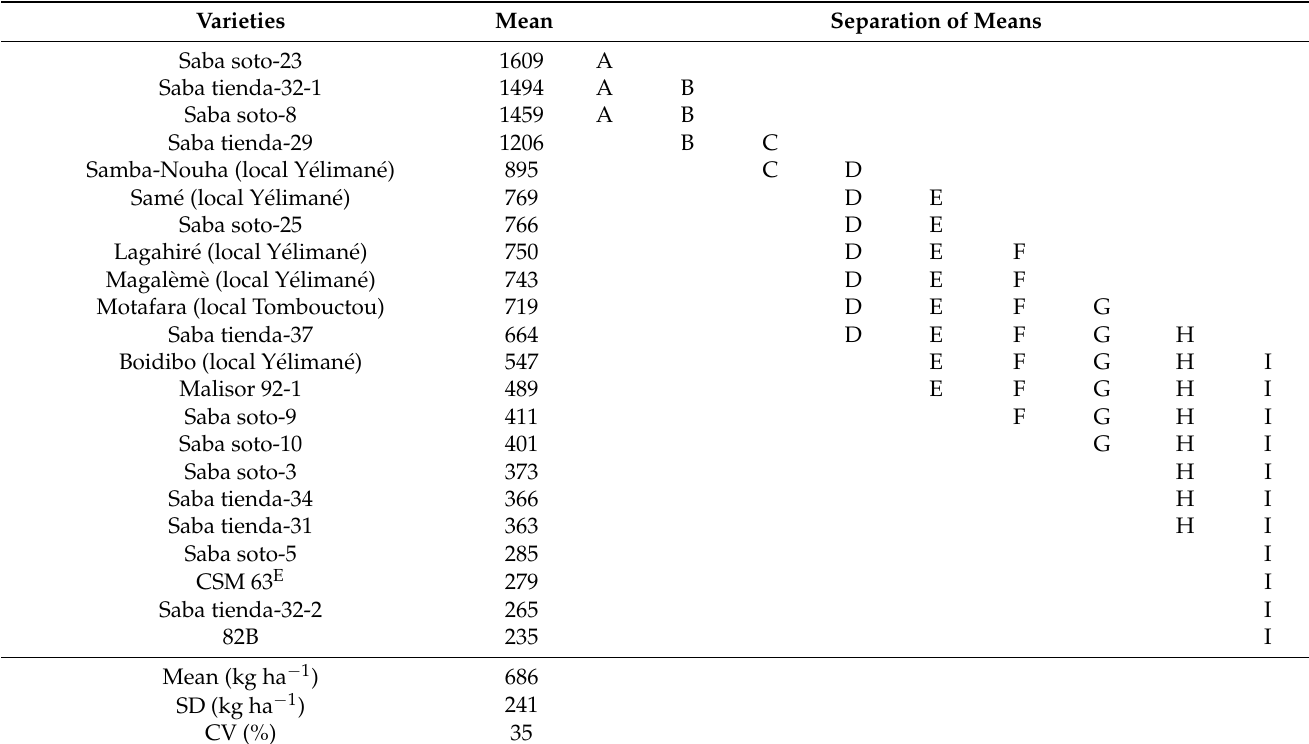
Table 4. Average sorghum grain yield (kg ha − 1 ) across sites of flood recession farming for 22 varieties tested in Yaguine, Gory, and Foungou in the 2014/2015 cropping season. Varieties with letters that do not overlap (A to I) are significantly different, according to a Newman–Keuls